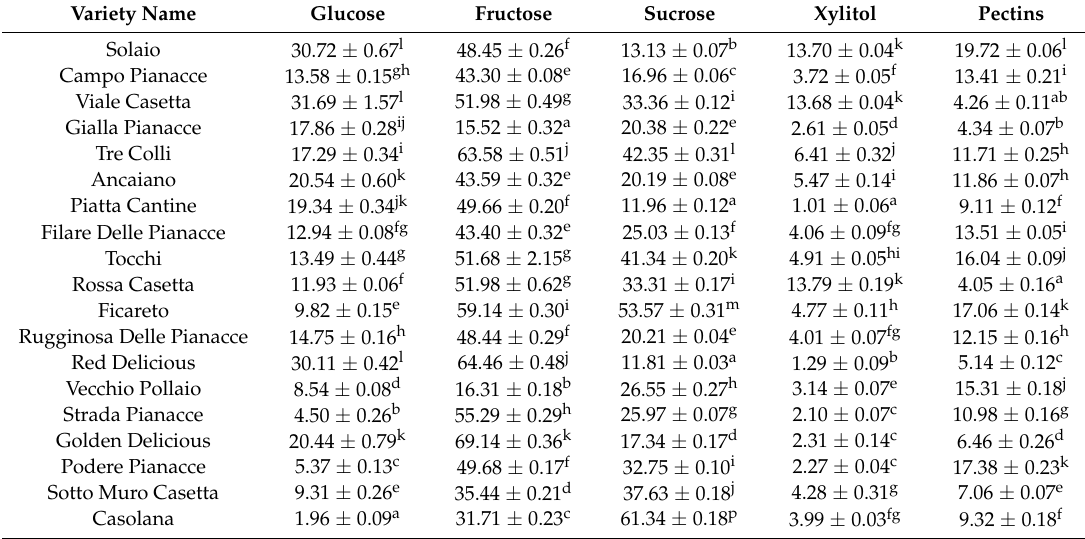
Table 2). Differently from fructose, the highest values of sucrose were measured in two ancient varieties: ‘Casolana’ with 61.34 mg/g FW and ‘Ficareto’ with 53.5 mg/g FW (Table 2). Table 2. The table shows the values ( ± SD) of free sugars and pectin (expressed as mg/g FW) in the ancient and commercial apples studied. Different letters indicate significant differences among values ( p <